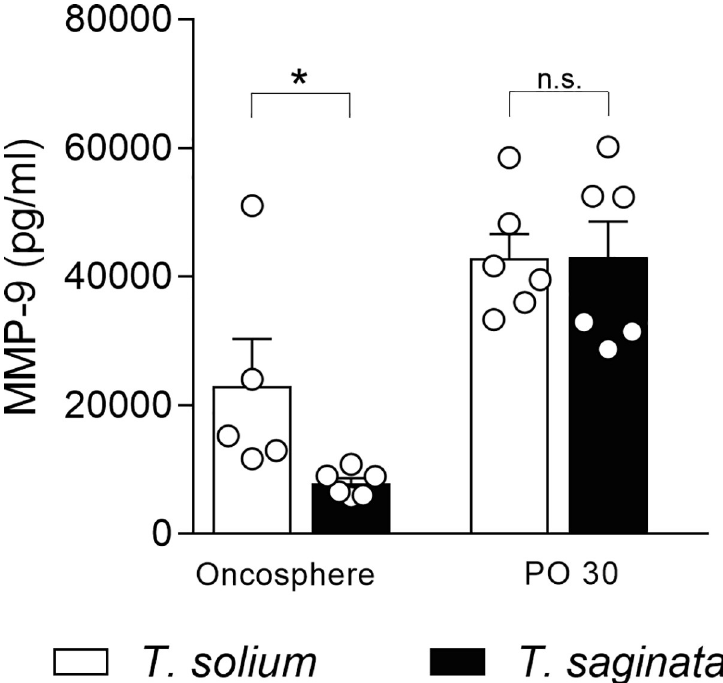
Fig 5. Production of MMP-9 by human PBMC stimulated with T . solium and T . saginata form. Culture supernatant was collected at 48 h from healthy human PBMC stimulated with 20 μ g/ml of activated oncosphere antigens and 20 μ g/ml of 30-day PO form antigens of T . solium and T . saginata . Data presented are the mean ± SEM of healthy human donors (n = 5–6) minus control. � P < 0.05 was considered statistically significant; n.s. = not